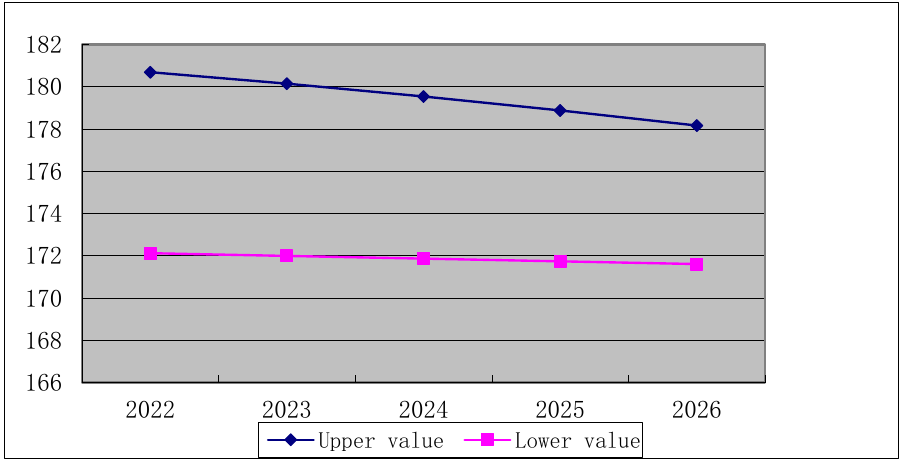
Figure 10. The variation interval of water requirement with the influence of primary industry in Hebei.